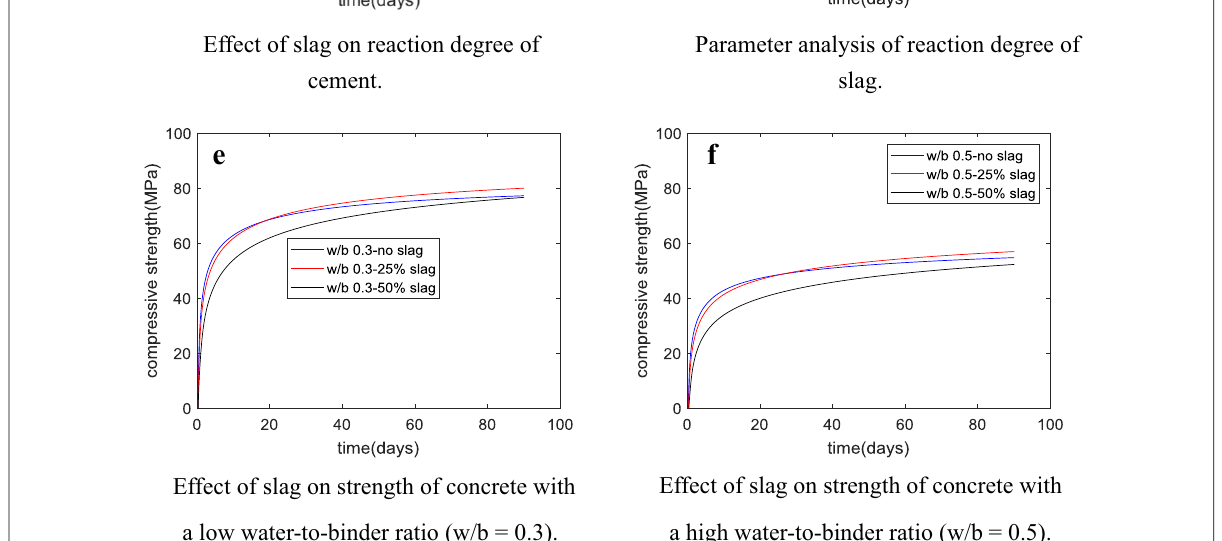
Fig. 1 Hydration–strength integrated model of HVS